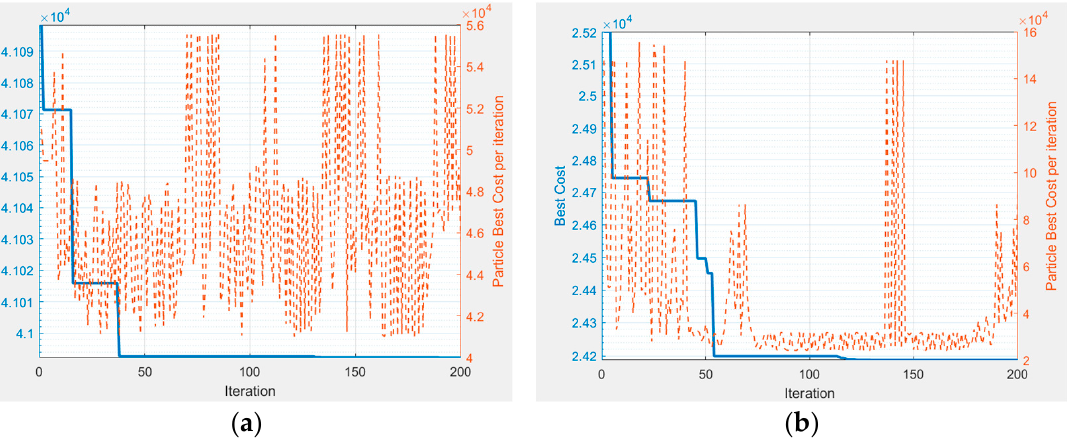
Figure 6. Particle best cost per iteration and best costs through all iterations of the proposed energy management method with PSO: ( a ) case 1; ( b ) case 2.